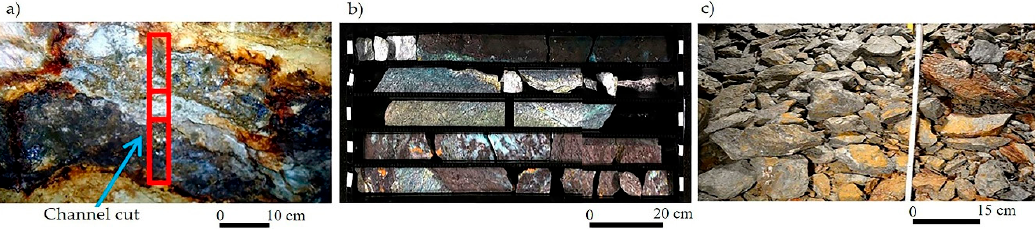
Figure 1. Images of ( a ) the mine face showing a channel cut with different intervals (the red boxes); ( b ) drill core samples; and ( c ) muck pile samples.